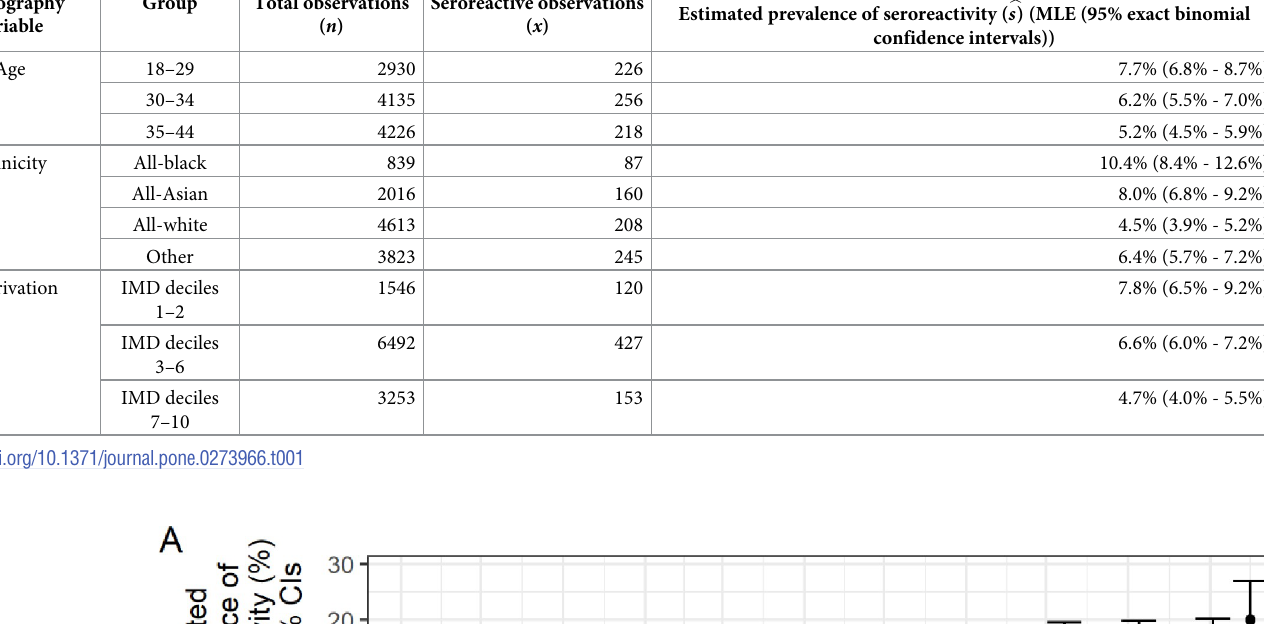
Table 1. Demographics of the study sample. The number of total observations and the number of seroreactive observations per group within each demography variable across the primary study period (October 2019 –September 2020). Demography variable